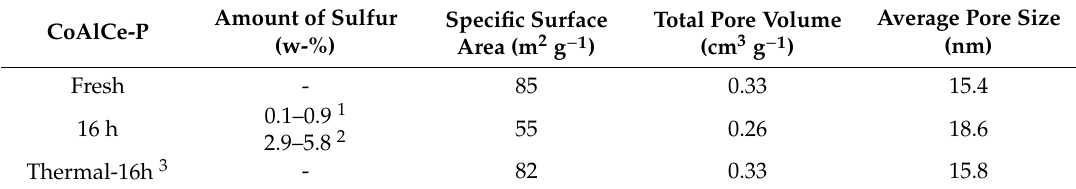
Figure 11. Reactants and products’ concentrations over the fresh and 16 h CoAlCe-P catalysts. Table 7. Amounts of sulfur, specific surface areas, total pore volumes and the average pore sizes of the fresh and 16 h